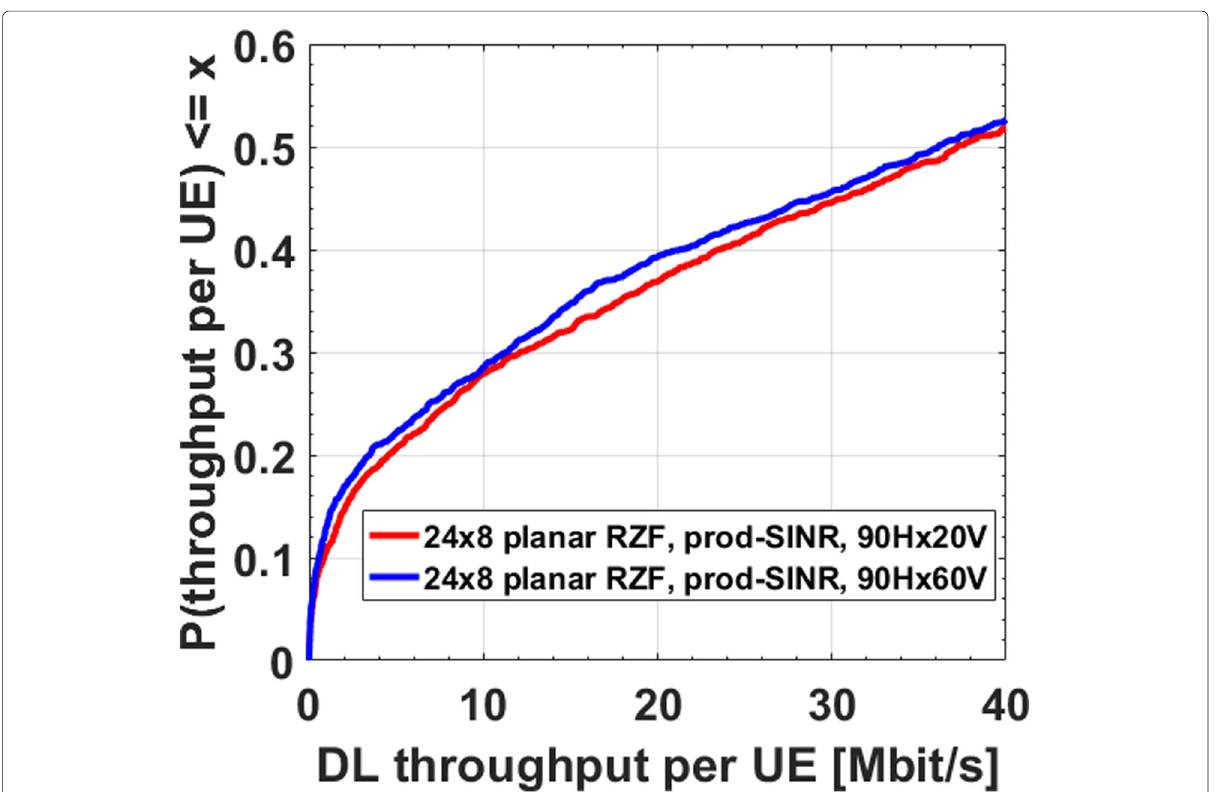
Fig. 14 DL throughput per UE between two different antenna elements with different physical vertical